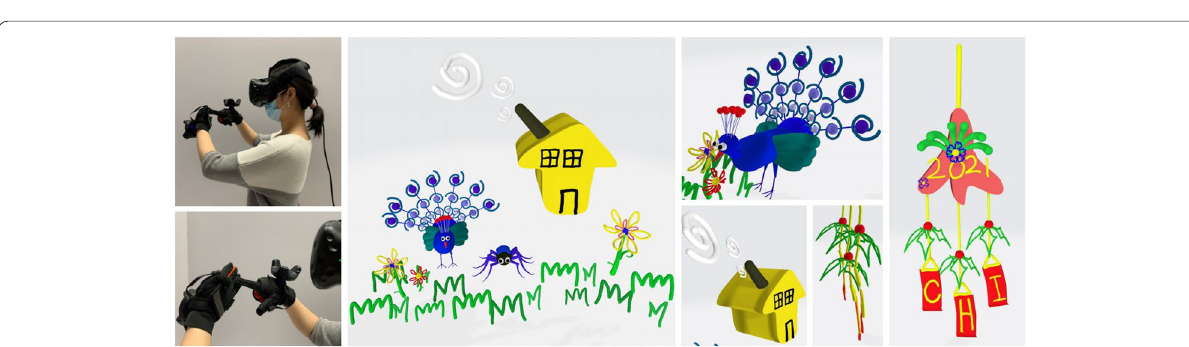
Fig. 39 Jiang et al.[88] proposed an algorithm to allow users to draw freely in the virtual